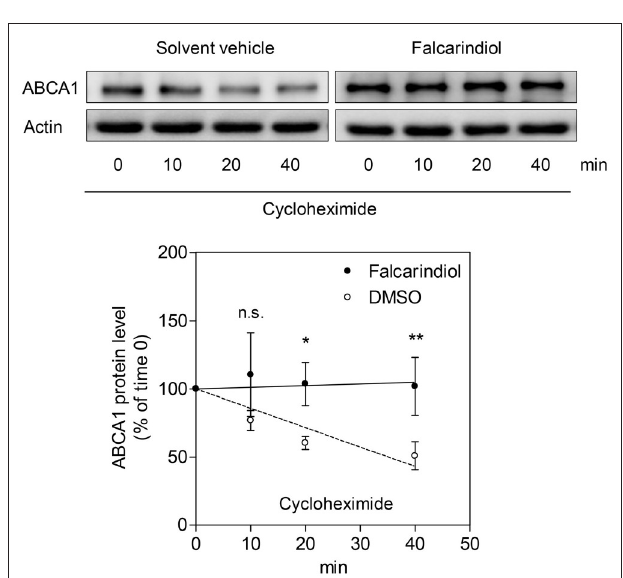
FIGURE 4 | Falcarindiol inhibits ABCA1 protein degradation. Differentiated THP-1 macrophages were stimulated with 10 µ M falcarindiol (black circles) or an equal amount of the solvent vehicle control (DMSO; white circles). After 24 h incubation, cells were treated with cycloheximide (140 µ M) and lysed at different time points (0, 10, 20, 40 min). Western blotting was used to monitor the decline of ABCA1 protein level upon cycloheximide treatment in the presence or absence of falcarindiol. All data are mean ± SD ( n = 3) and vs. solvent vehicle control (DMSO): * p < 0.05, ** p < 0.01, n.s. not significant (two-way